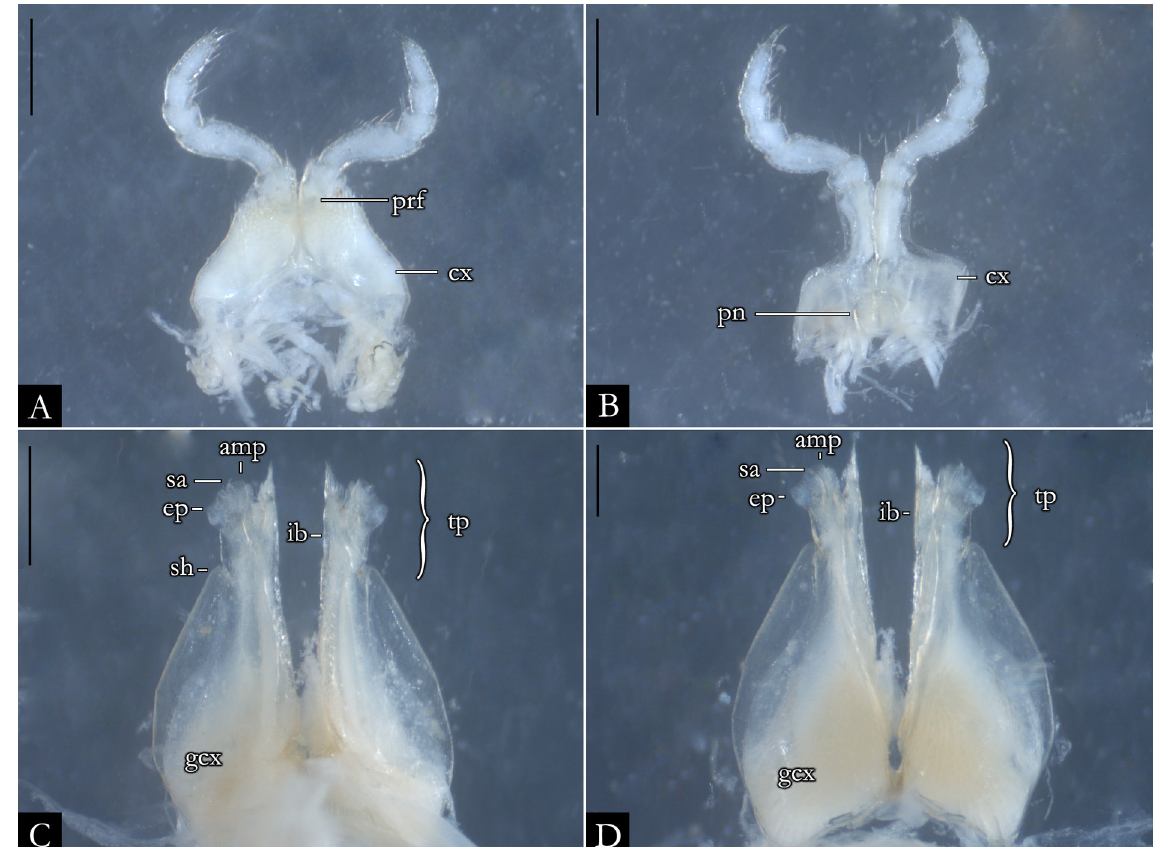
Fig. 92. Pseudonannolene meridionalis Silvestri, 1902, ♂ (NHMD). A . First leg-pair. B . Second leg- pair. C . Gonopods, in oral view. D . Gonopods, in anal view. Abbreviations: see Material and methods. Scale bars: A–B = 0.5 mm; C = 0.25 mm; D = 0.15 mm.